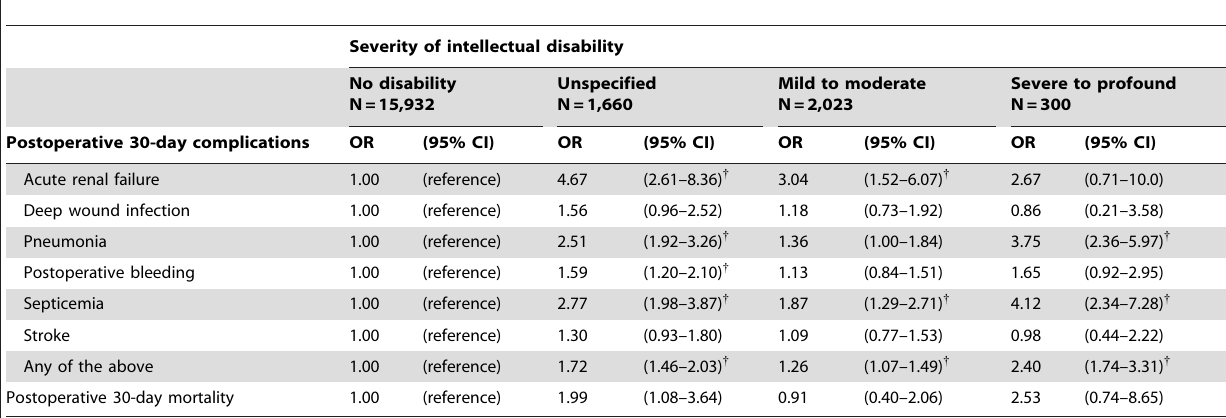
Table 3. Risk of postoperative 30-day mortality and complications by severity of intellectual disability in multiple logistic regression models *